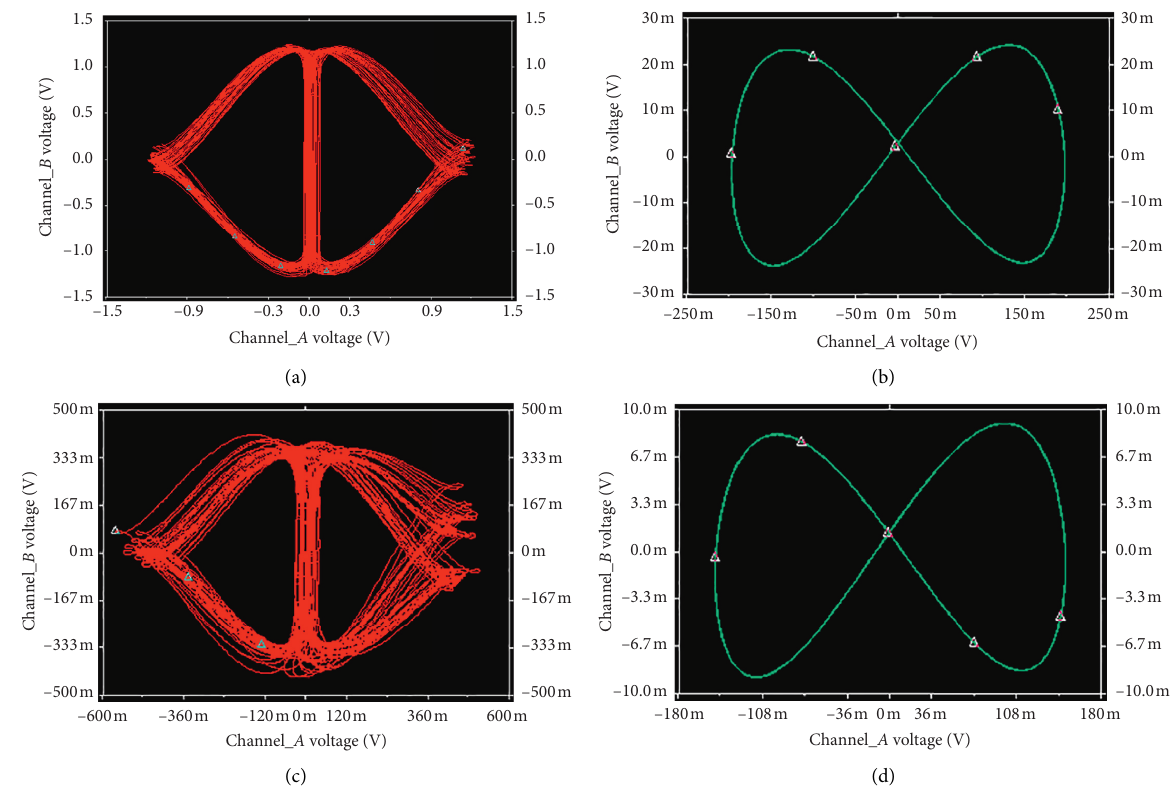
Figure 10: Circuit simulation results of case B. (a) a � − 0.2, b � 0, c � 1, e � 0. (b) a �− 0.2, b � 0, c � 1, e � − 2. (c) a � 0.001, b � 0, c � 1, e � 0. (d) a � 0.001, b � 0, c � 1, e � −